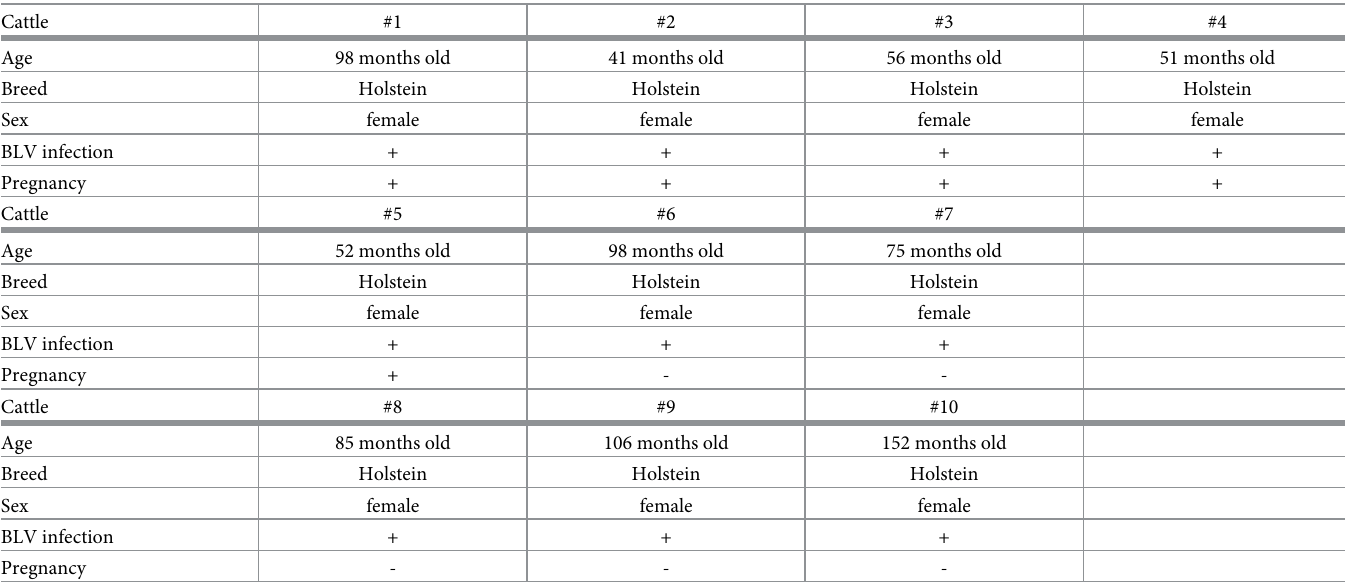
Table 1. BLV-infected cattle used in this